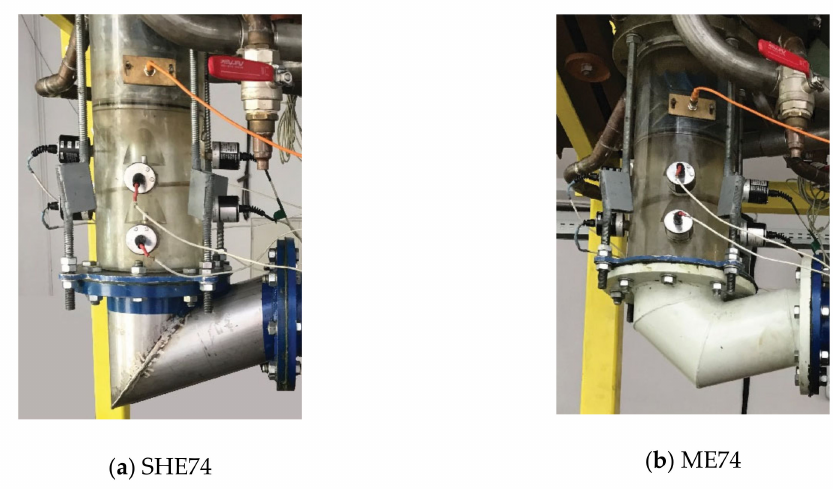
Figure 2. Photos of the simplified elbow draft tube geometries installed on test rig: ( a ) 74 ◦ Sharp Heel Elbow (SHE74) ( b ) 74 ◦ Modified Elbow